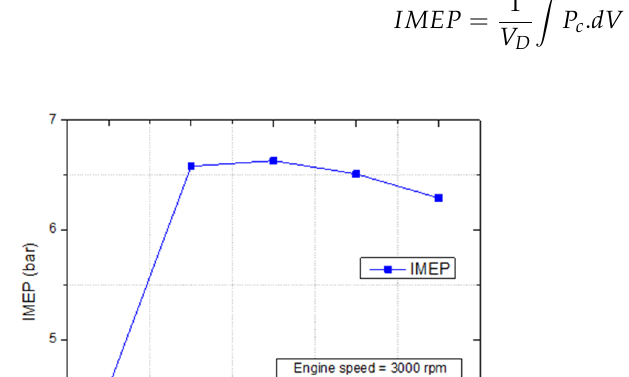
Figure 8. ERE versus IPD/B.